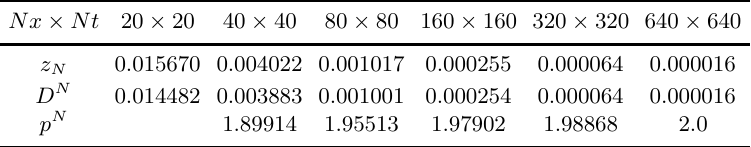
Table 1. Convergence analysis for a test